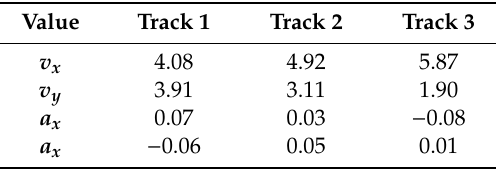
Figure 15. The history matching results of the acceleration in the X-direction and Y-direction through the MHT-EnKF. Table 2. History matching results of the accelerations and velocities in the X-direction and Y-direction (units: km /